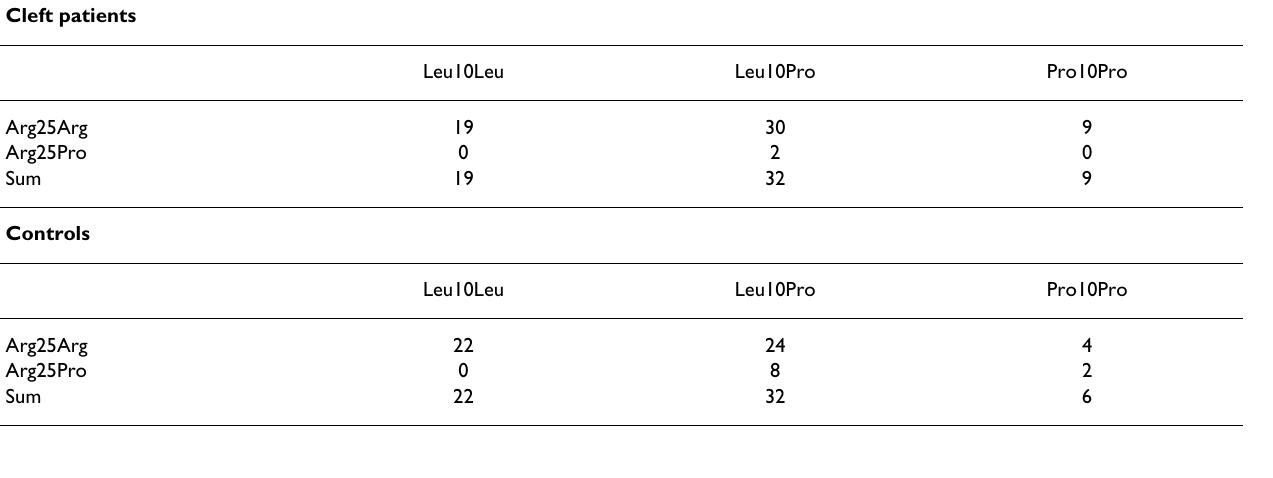
Table 3: No significant difference in Leu10Pro polymorphism between patient and control groups could be revealed, although the exchange of leucine by proline at codon 10 was positively correlated with Arg25Pro genotype calculated by Yates corrected Chi-square test (p <